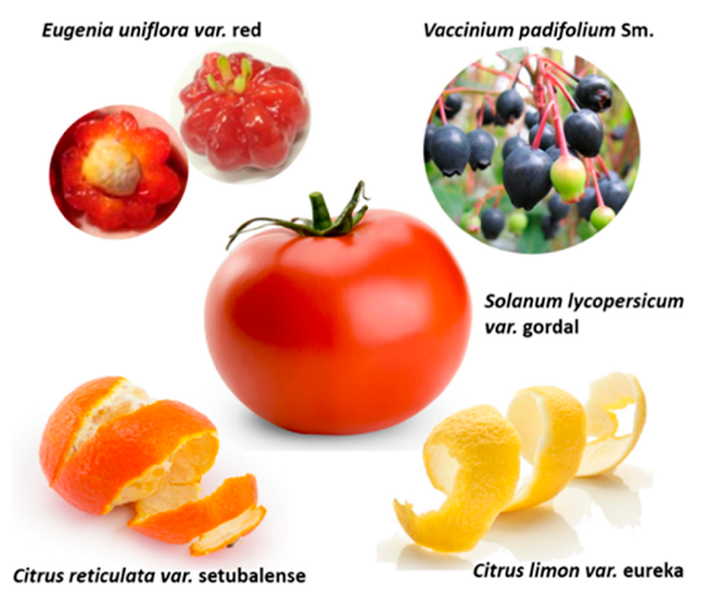
Figure 1. Fruits under study: Pitanga ( Eugenia uniflora variety red) seeds and pulp, uva-da-serra ( Vaccinium padifolium Sm.), tomato ( Solanum lycopersicum variety gordal), lemon ( Citrus limon variety eureka ) peels and juice and tangerine ( Citrus reticulata variety setubalense) peels and juice.